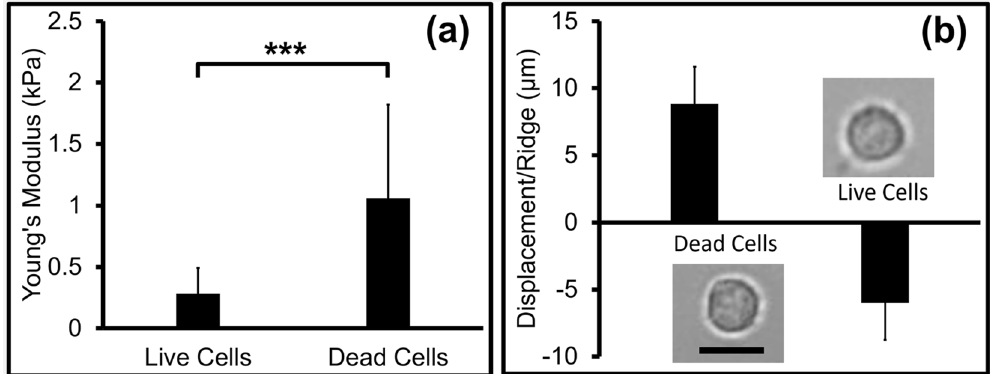
Figure 2. Measurements for live and dead cells ( a ) Young’s modulus of live and dead cells obtained from AFM measurement ( *** p- value < 0.0001) ( N = 30); ( b ) average displacement of dead and live cells per ridge in the microfluidic device ( N = 50); optical micrographs of live and dead cells are shown here (scale bar is 20 µ